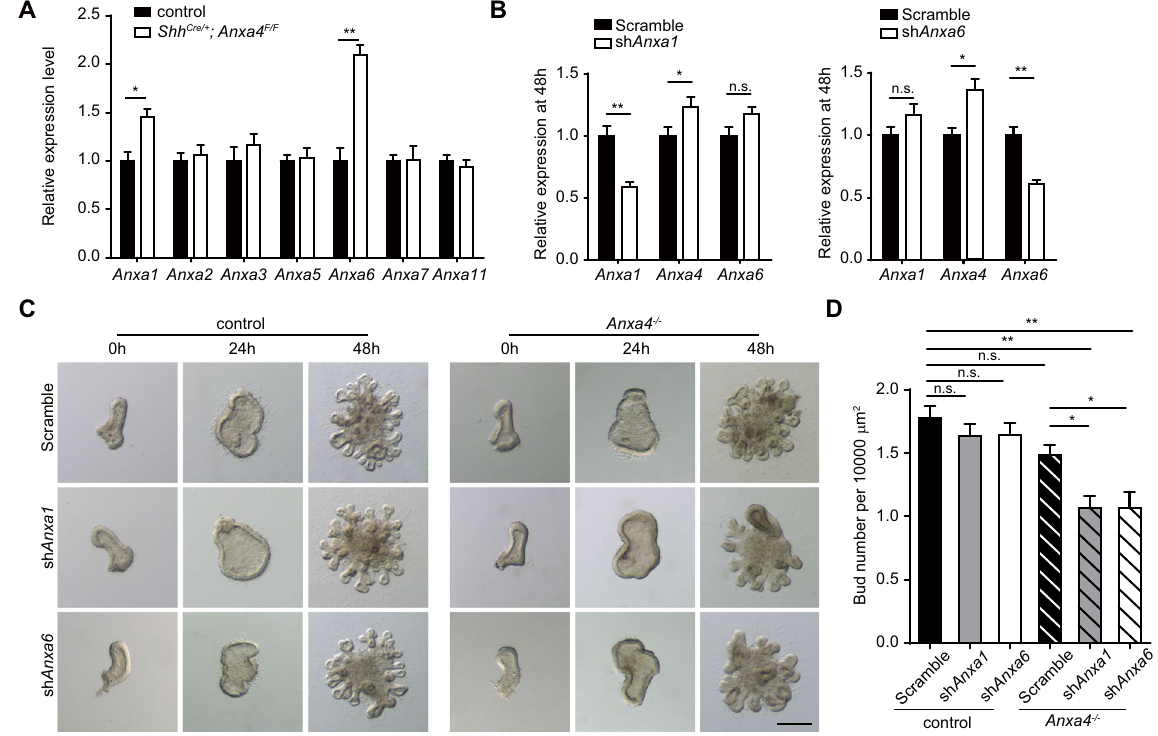
Figure 5. Anxa4 functions redundantly with Anxa1 and Anxa6 in regulating endoderm budding process. ( A ) Relative expression level of Anxa1, Anxa2, Anxa3, Anxa5, Anxa6, Anxa7 and Anxa11 in control and Shh Cre/ + ; Anxa4 F/F lungs. ( B ) The relative expression level of Anxa1 , Anxa4 and Anxa6 at 48 h in cultured control lung endoderm treated with Scramble shRNA, or sh Anxa1 , or sh Anxa6 . The knockdown efficiency of sh Anxa1 or sh Anxa6 in cultured lung endoderm explants at 48 h was about 40%. Data are presented as mean ± S.E.M, n = 3. *** p < 0.001; Student’s t -test. ( C ) Representative images of cultured control or Anxa4 − / − lung endoderm explants treated with Scramble shRNA, sh Anxa1 , or sh Anxa6 . Scale bar: 200 μ m. ( D ) Quantification of bud number of different lung endoderm groups in (B). Data are presented as mean ± S.E.M, n = 12. n.s., not significant; * p < 0.05; *** p < 0.001; Student’s t